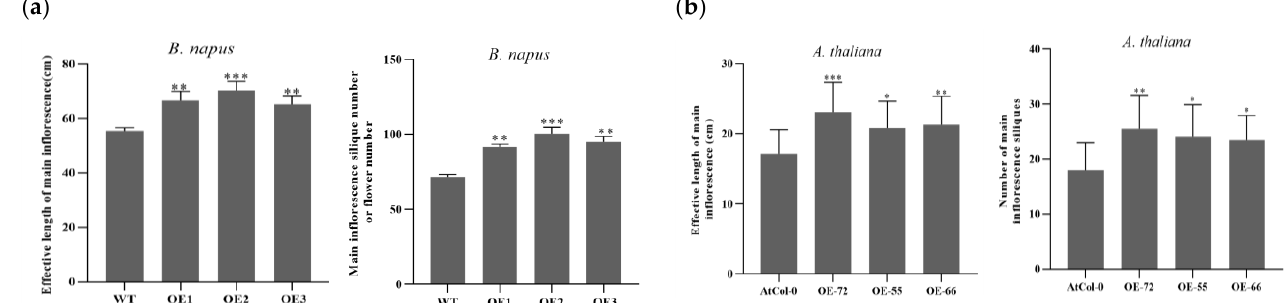
Figure 2. The expression of BnKAT2 in transgenic B. napus ( a ) and A. thaliana ( b ) , relative to their respective wild-type expression levels. Values are means ± SD of three independent biological replicates. *** indicate significant differences at the 0.001 levels.